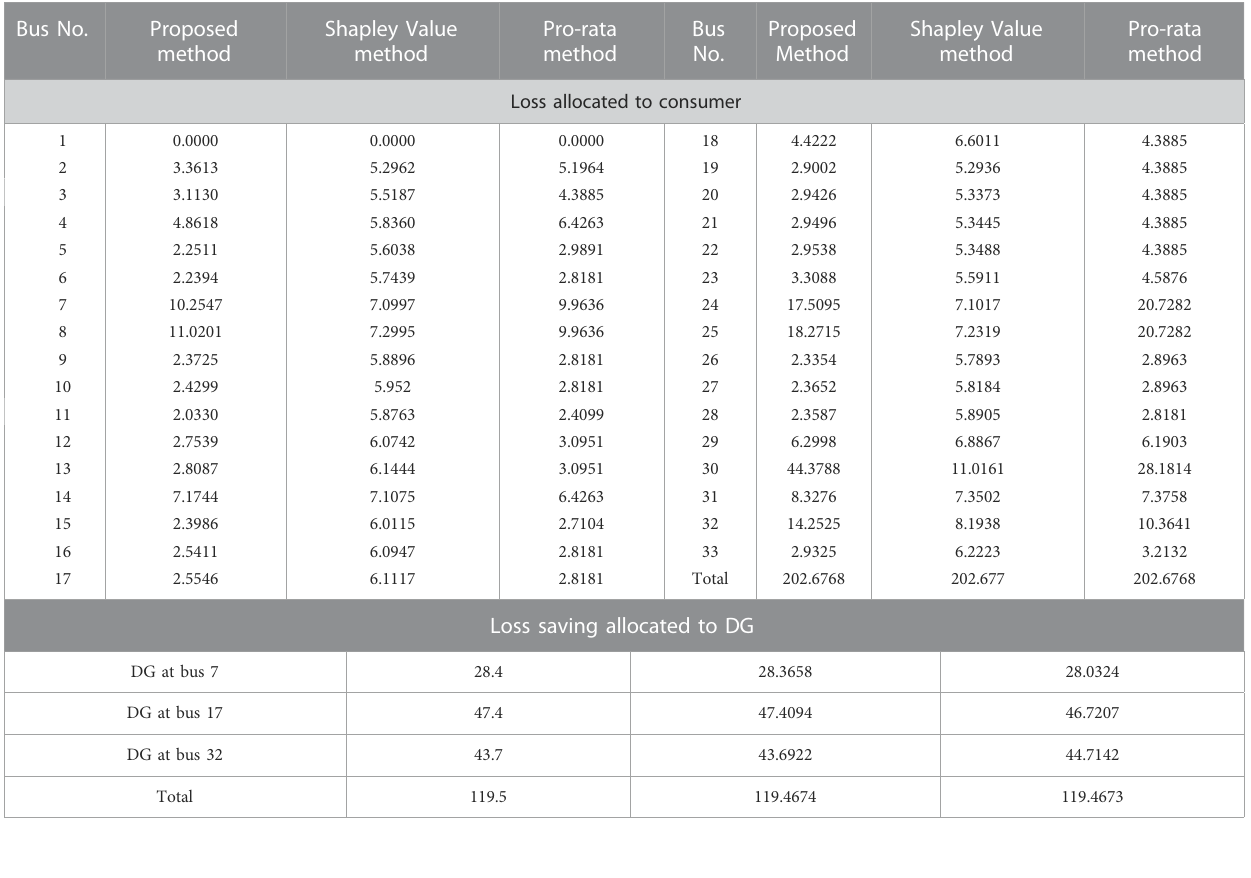
TABLE 3 Comparison of allocated losses (in kW) and loss saving (in kW) to load and DG, respectively, of 33-bus DS by all three given methods. Bus